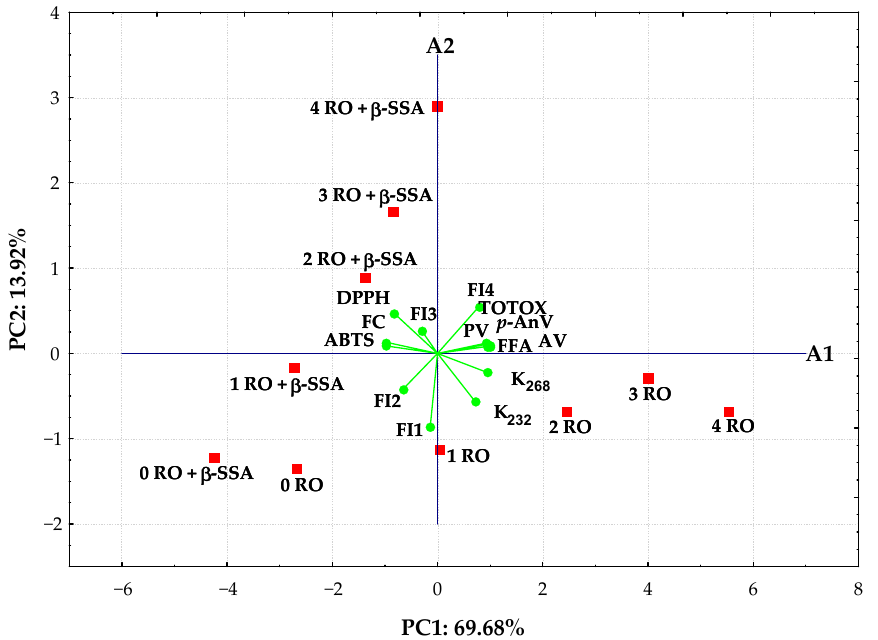
Figure 6. Bi-plot of scores and loadings of data obtained from fluorescence spectra, oxidative, and antioxidant parameters of refined rapeseed oils without and with β -sitosteryl sinapate stored during 4 weeks.